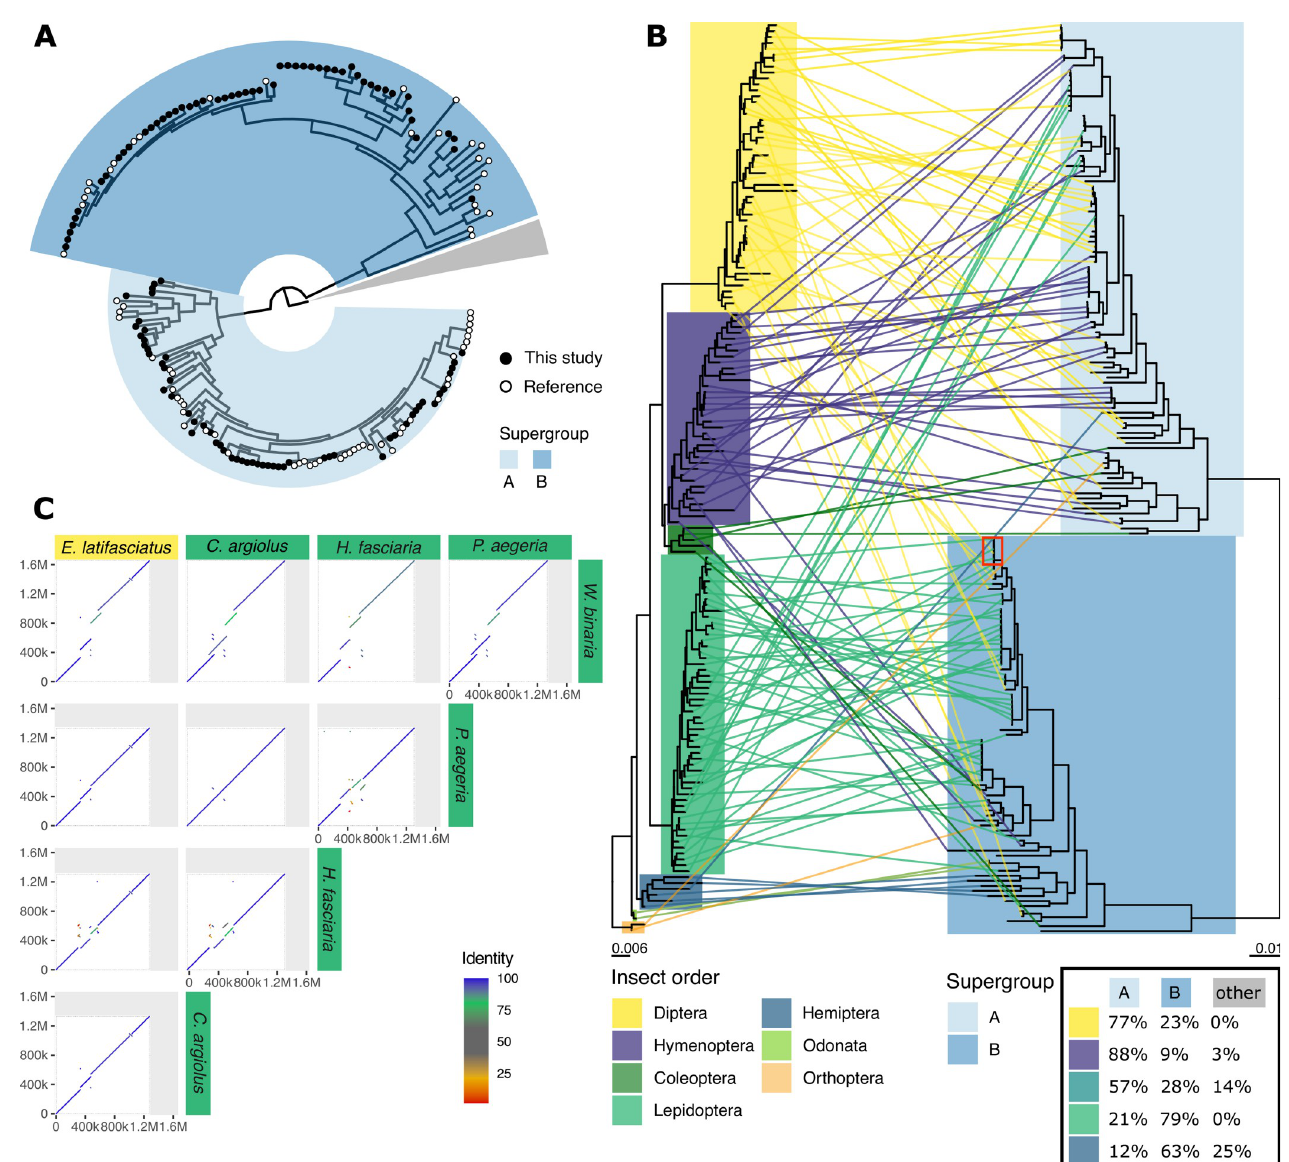
Fig 2. Wolbachia DToL genomes expand known phylogeny. (A) Circular phylogeny of supergroup A and B Wolbachia , visualised with the root placed between the A and B supergroups and the remaining supergroups (C, D, E, F, J, S; nodes collapsed as grey wedge), highlighting newly sequenced genomes (black tip labels) and genomes from public databases (white). ( B) Incongruence between host topology (left) and supergroup A and B Wolbachia topology (right) is shown as a tanglegram. Overview of the supergroups infecting diverse insect orders is given in a table (inset, bottom right). A red box is drawn to point to a host switching event; see panel C. (C) Example of a host switching event, where the Wolbachia of the hoverfly Eupeodes latifasciatus has high nuclear sequence identity and genome colinearity to four Wolbachia genomes assembled from